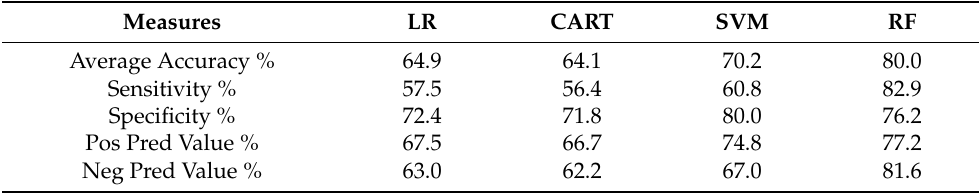
Table 2. Measures of classification performance for a test set using logistic regression and machine learning models built from an upscaled data